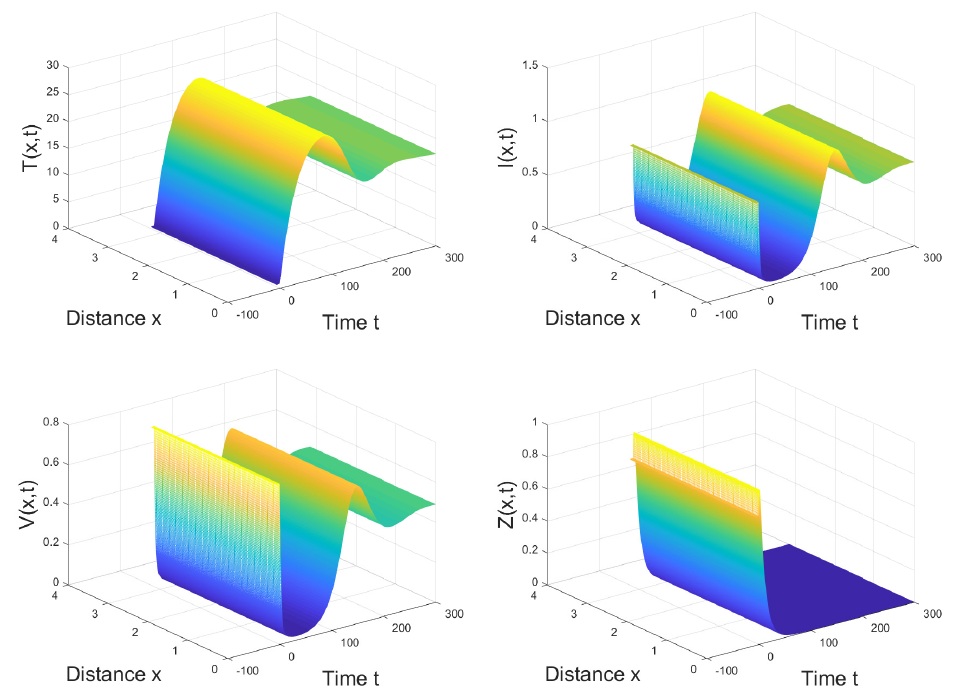
Figure 3. When D = 3, R 1 ≤ 1 < R 0 , the CTL -inactivated equilibrium E 1 is globally asymptotically stable. From Figure 3, we can see that the population in the compartment CTLs tends to